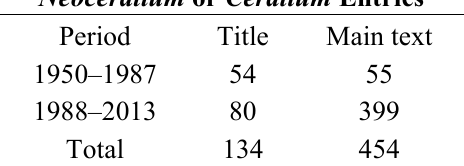
Table 1. Results of Web of Knowledge bibliographic search for “ Neoceratium ” or “ Ceratium ” entries within the title or main